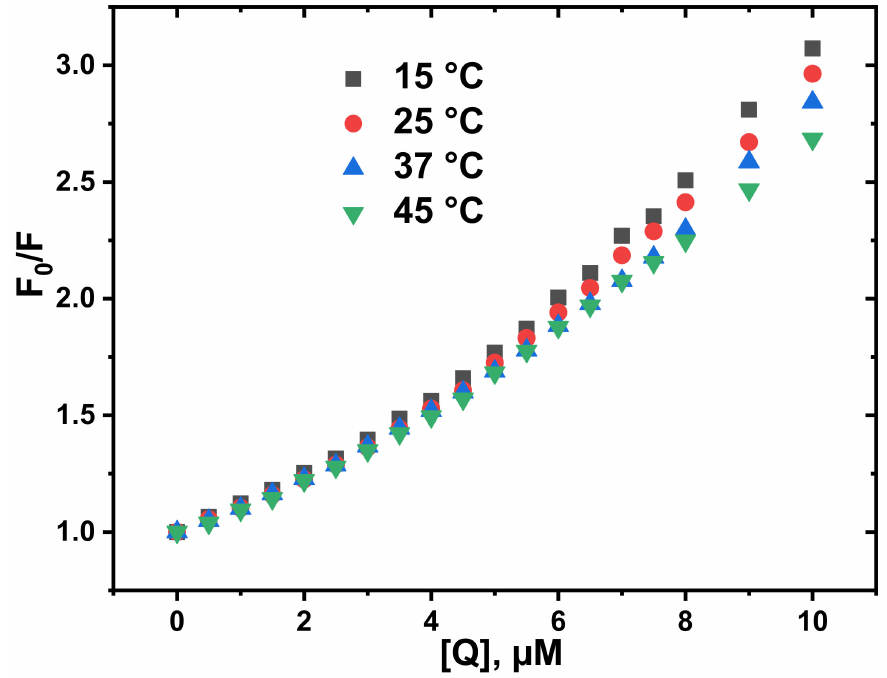
Figure 6. Stern–Volmer plots of HSA–PAZ interaction.